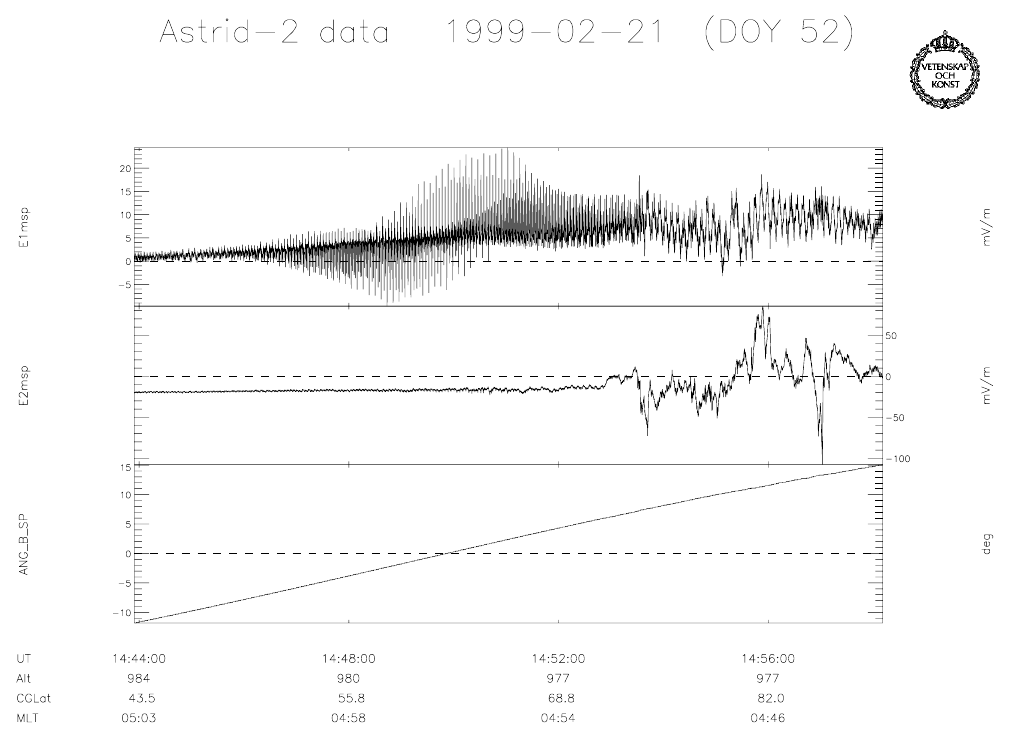
Fig. 4. Spurious electric fields observed when the magnetic field lies in the satellite spin plane. Panels from top to bottom show the components of the measured electric field in the spin plane most parallel and perpendicular to the ambient magnetic field, and the angle between the magnetic field and the spin